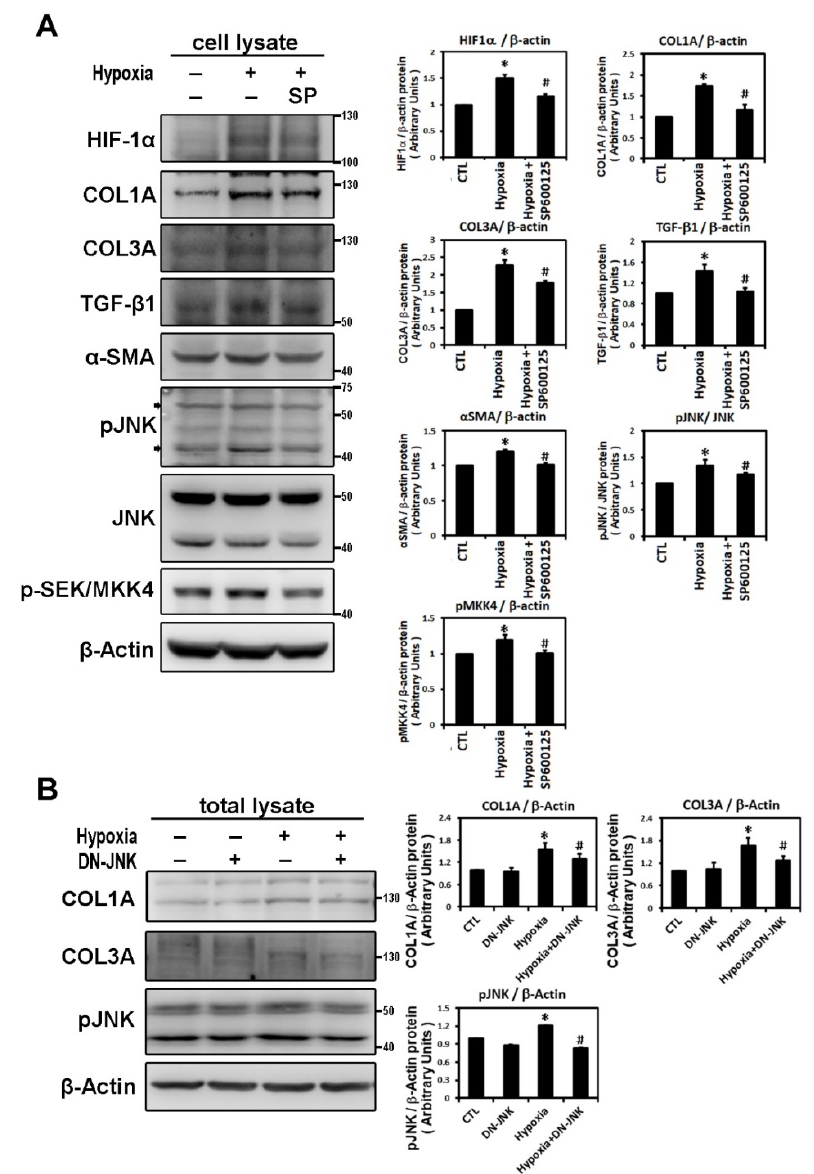
Figure 3. Hypoxia activates the JNK pathway to modulate fibrosis-related proteins expression. Panel A : Effect of JNK pathway inhibitor on the hypoxia-induced expression of indicated protein. Representative Western blots and levels of HIF-1 α , fibrosis-related proteins (COL1A, COL3A, TGF- β 1, α -SMA) and phosphorylated JNK and SEK/MKK4 in HL-1 cells that were pre-incubated with SP600125 (10 − 5 M) or DMSO as a vehicle for 30 min, then treated with hypoxia stress (1% O 2 ) for 6 h. The bar graph shows the value of each sample relative to that of control cells that received vehicle only. The data are mean ± SEM ( n = 4 per group, * p < 0.05 vs. control; # p < 0.05 vs. hypoxia) from four independent experiments. Panel B : Dominant-negative-JNK (DN-JNK) gene transfection attenuated hypoxia-induced COL1A, COL3A and p -JNK expression in HL-1 cells. Representative Western blots and COL1A and COL3A levels in HL-1 cells transfected with vehicle pCDN3 (CTL) or DN-JNK for 24 h before 6h-hypoxia treatment. The data are mean ± SEM ( n = 3 per group, * p < 0.05 vs. control; # p < 0.05 vs. hypoxia) from three independent experiments.